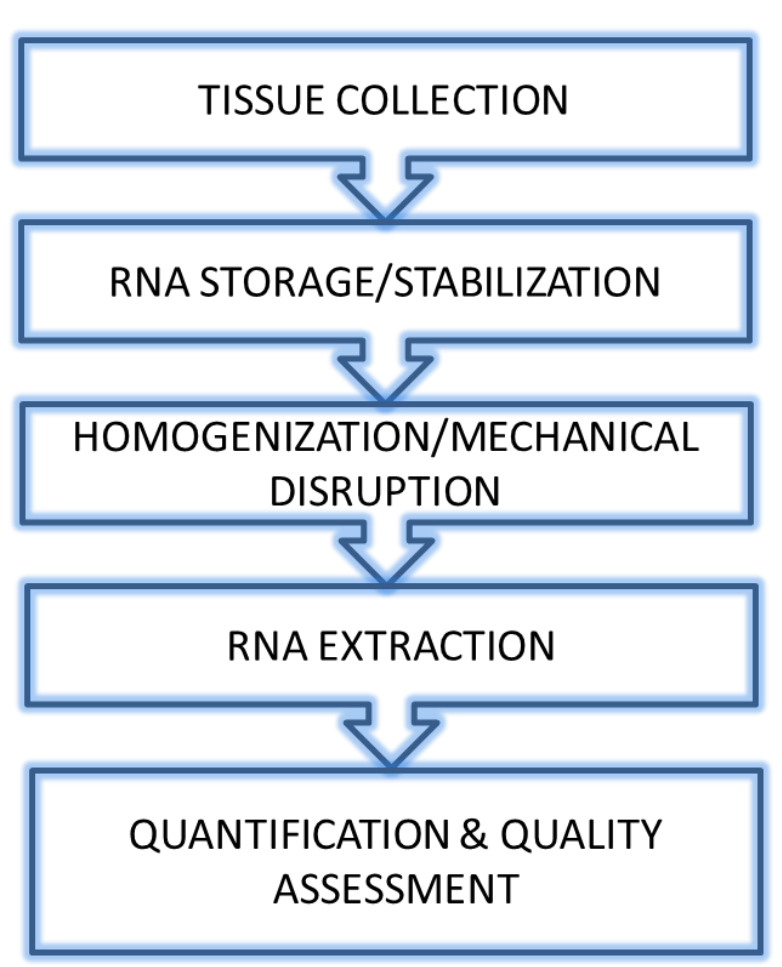
Figure 1. Flowchart of the main steps of RNA extraction.